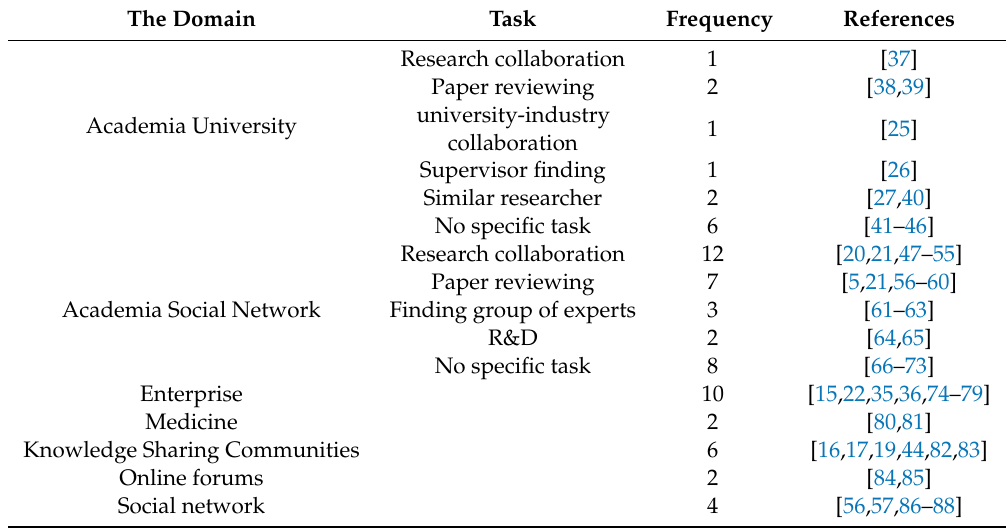
Table 3. Expert finding systems’